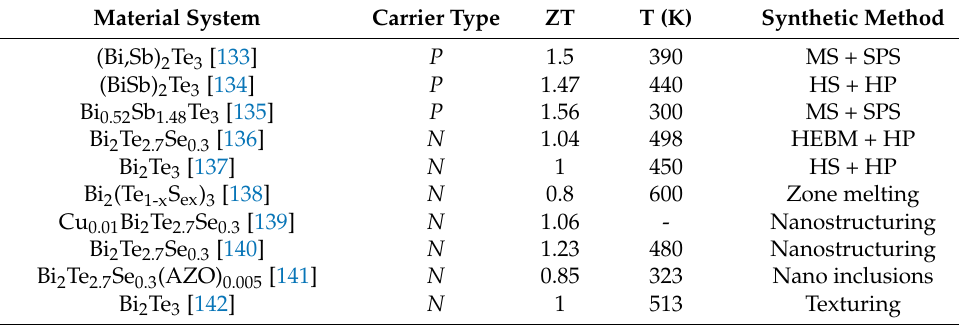
Table 6. TE properties of nanostructured materials by various synthetic methods. Material